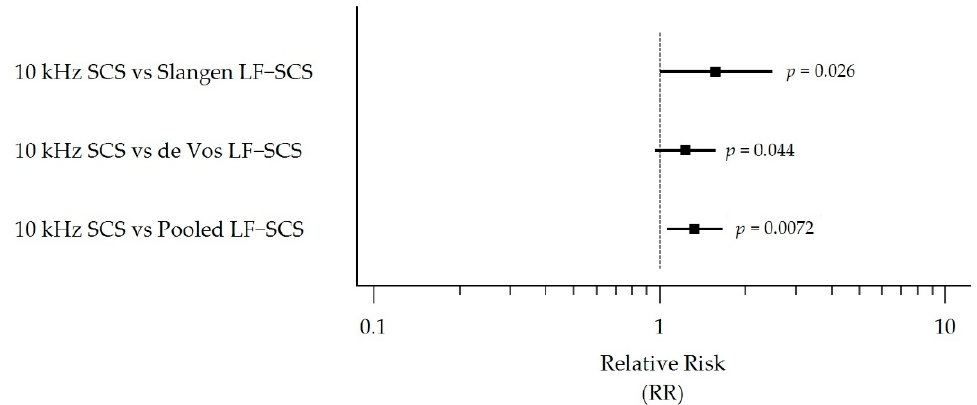
Figure 5. Forest plot comparison of the permanent implant population responder rates at 6 months, showing RR with 95% CI. The permanent implant population comprised subjects who completed the SCS trial phase and received a permanent system. Abbreviations: CI, Confidence Interval; LF-SCS, Traditional Low-Frequency Spinal Cord Stimulation; RR, Relative Risk; SCS, Spinal Cord Stim- ulation.